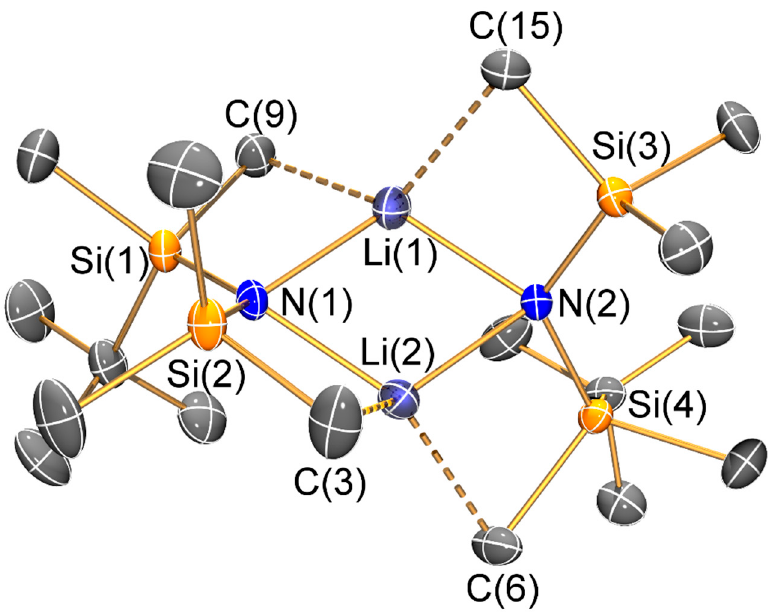
Figure 3. Molecular structure of [Li{ μ -N(Si t BuMe 2 )(SiMe 3 )}] 2 ( 2 ) with selective atom labelling. Displacement ellipsoids set at 30% probability level and hydrogen atoms omitted for clarity.